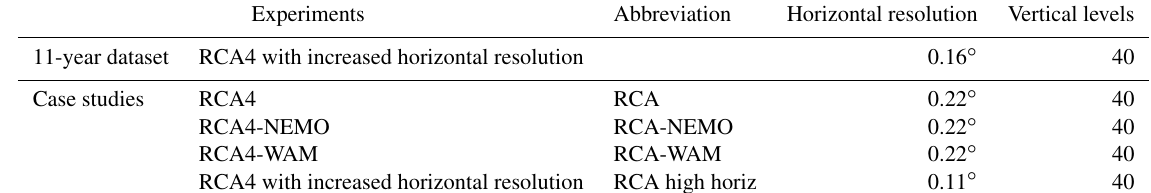
Table 2. Overview of the model experiments used for the analysis of an 11-year dataset and the model evaluation based on two case studies.